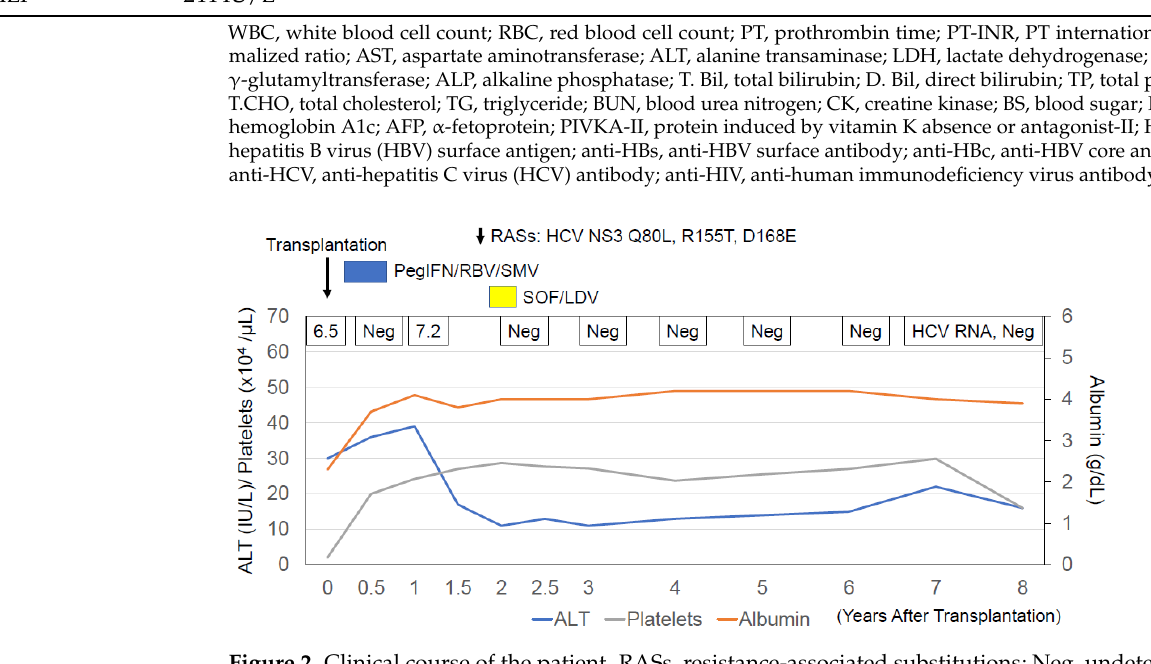
Figure 2. Clinical course of the patient. RASs, resistance-associated substitutions; Neg, undetectable HCV RNA; PegIFN, peginterferon α -2b; RBV, ribavirin; SMV, simeprevir; SOF, sofosbuvir; LDV, ledipasvir; ALT, alanine transaminase.